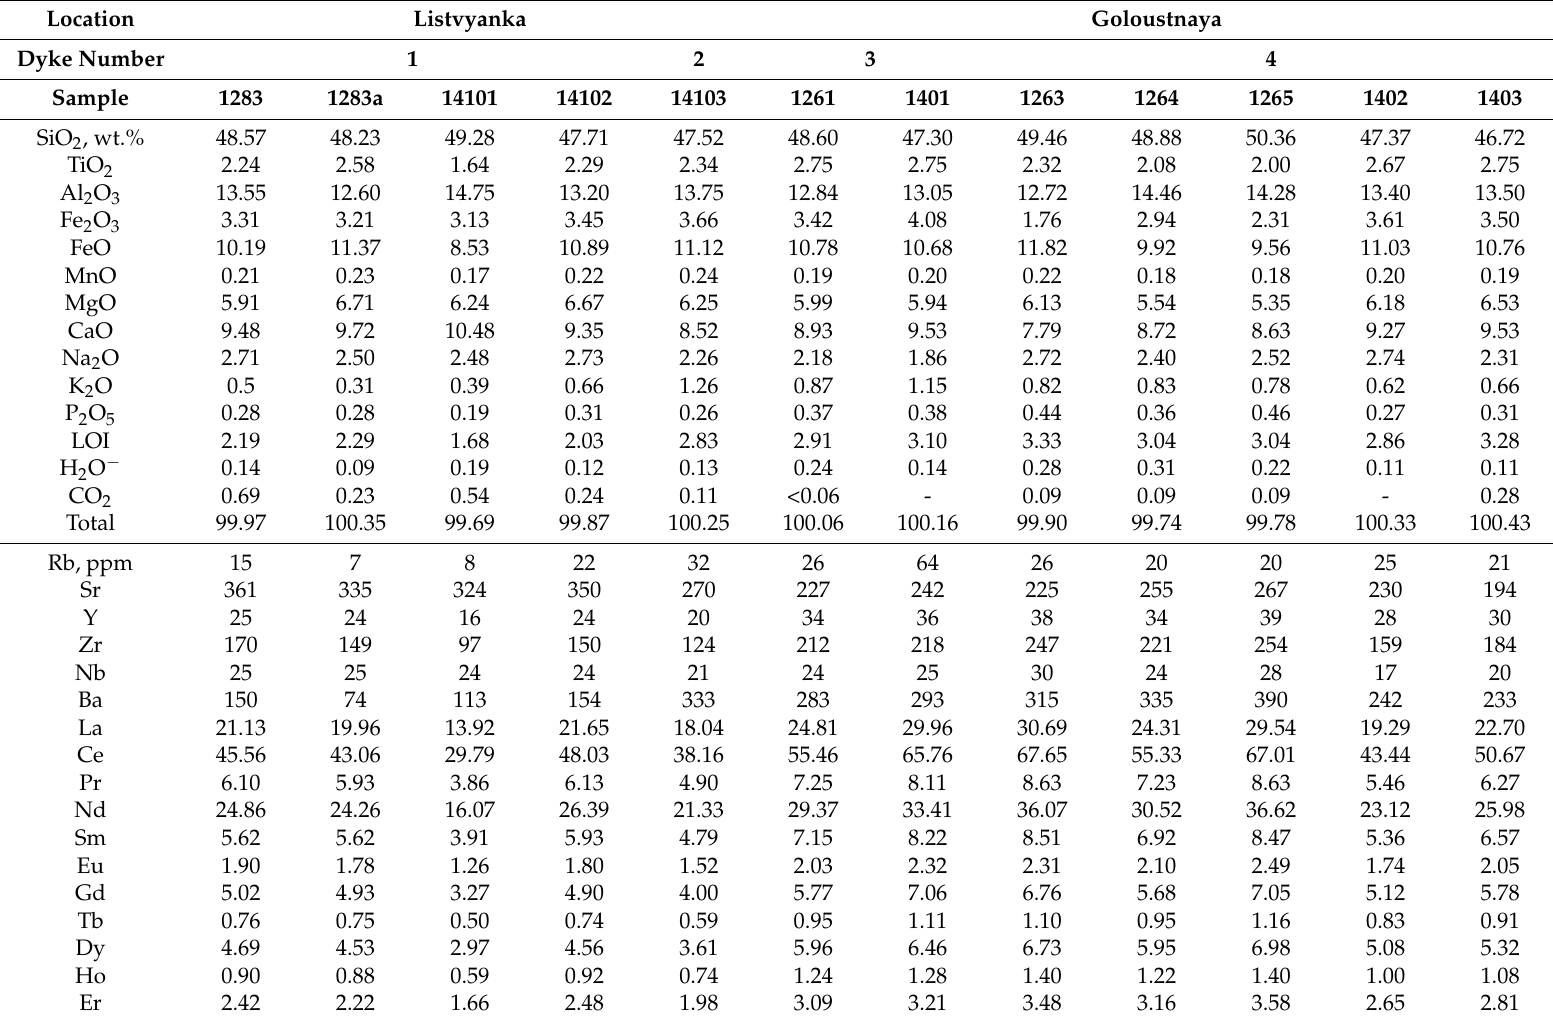
Table 1. Geochemical compositions of the Listvyanka and Goloustnaya